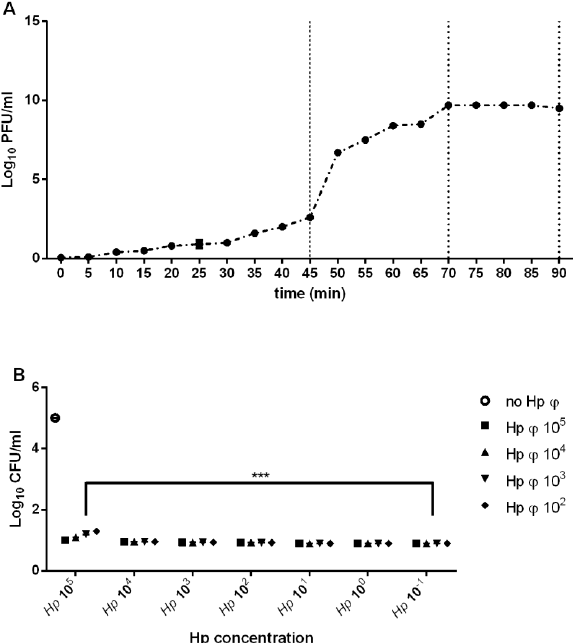
Figure 1. Phage characterization. ( A ) One step growth curve of phage. ( B ) Representation of phage activity on Hp growth. The figure illustrates the bacterial plate counts (CFU / mL) after the activity of the phage. Each value is the mean ± SD of three independent experiments. *** p < 0.001. Statistical analysis was performed with Student’s t -test. Values are expressed as the mean ± SD from three independent experiments with three replicates for each data point. Table 1. Phage host range determination on different samples from the gastroenterology department of “Ospedale Evangelico Villa Betania” Naples.